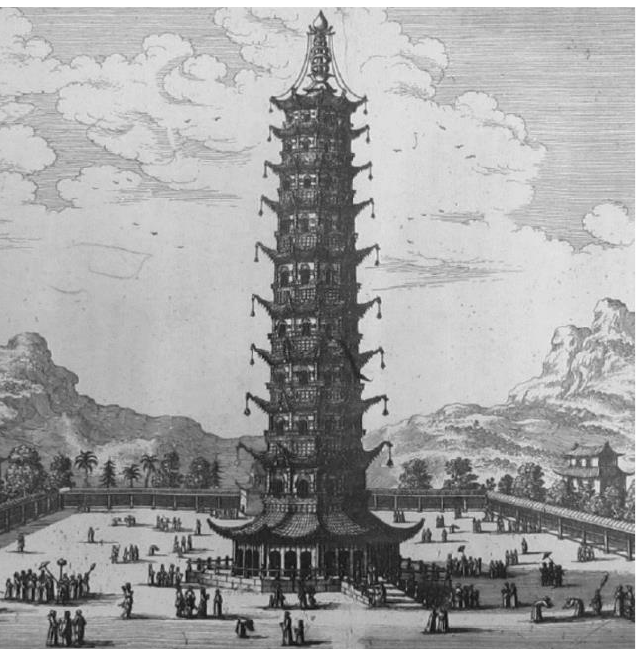
Figure 2. The Porcelain Tower of Nanjing, published in England by Johan Nieuhof in 1669 (source: Ref.[34])